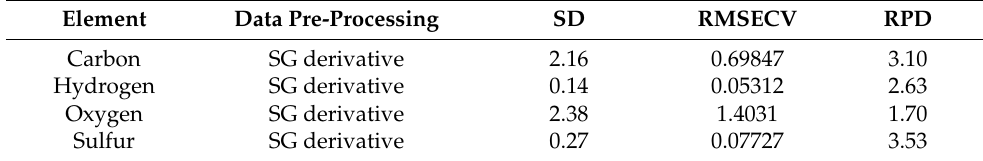
Table 2. RPD of mixed